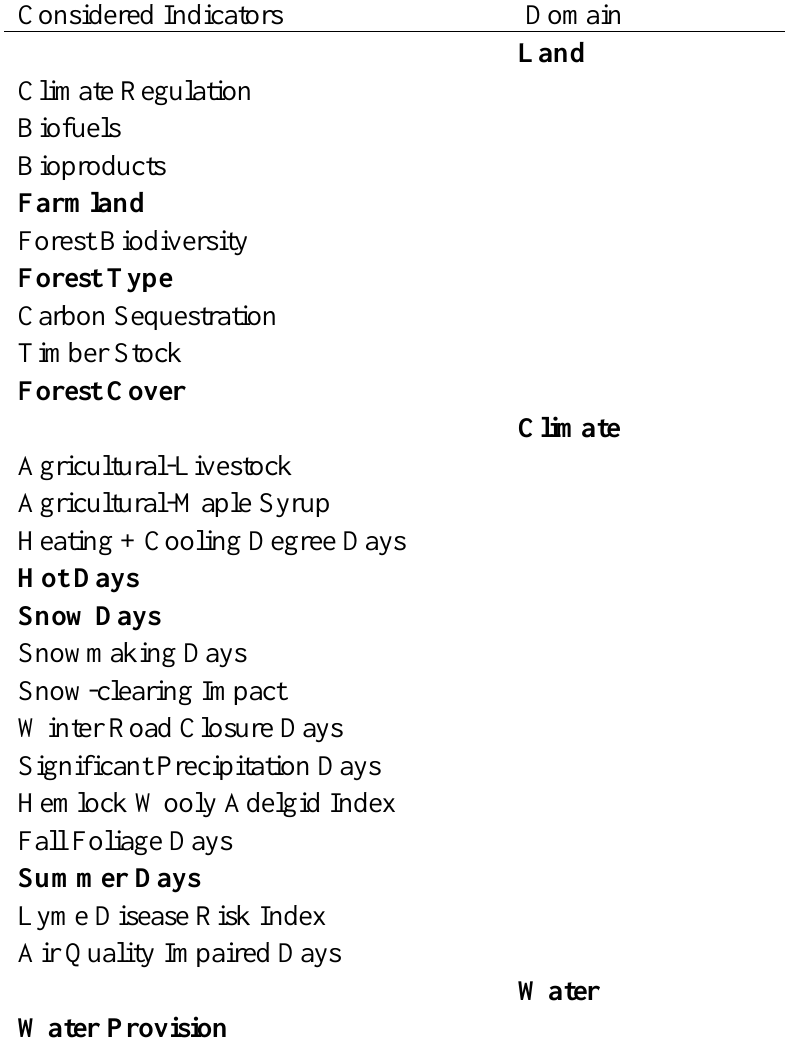
Table A2.1. Considered Indicators Considered